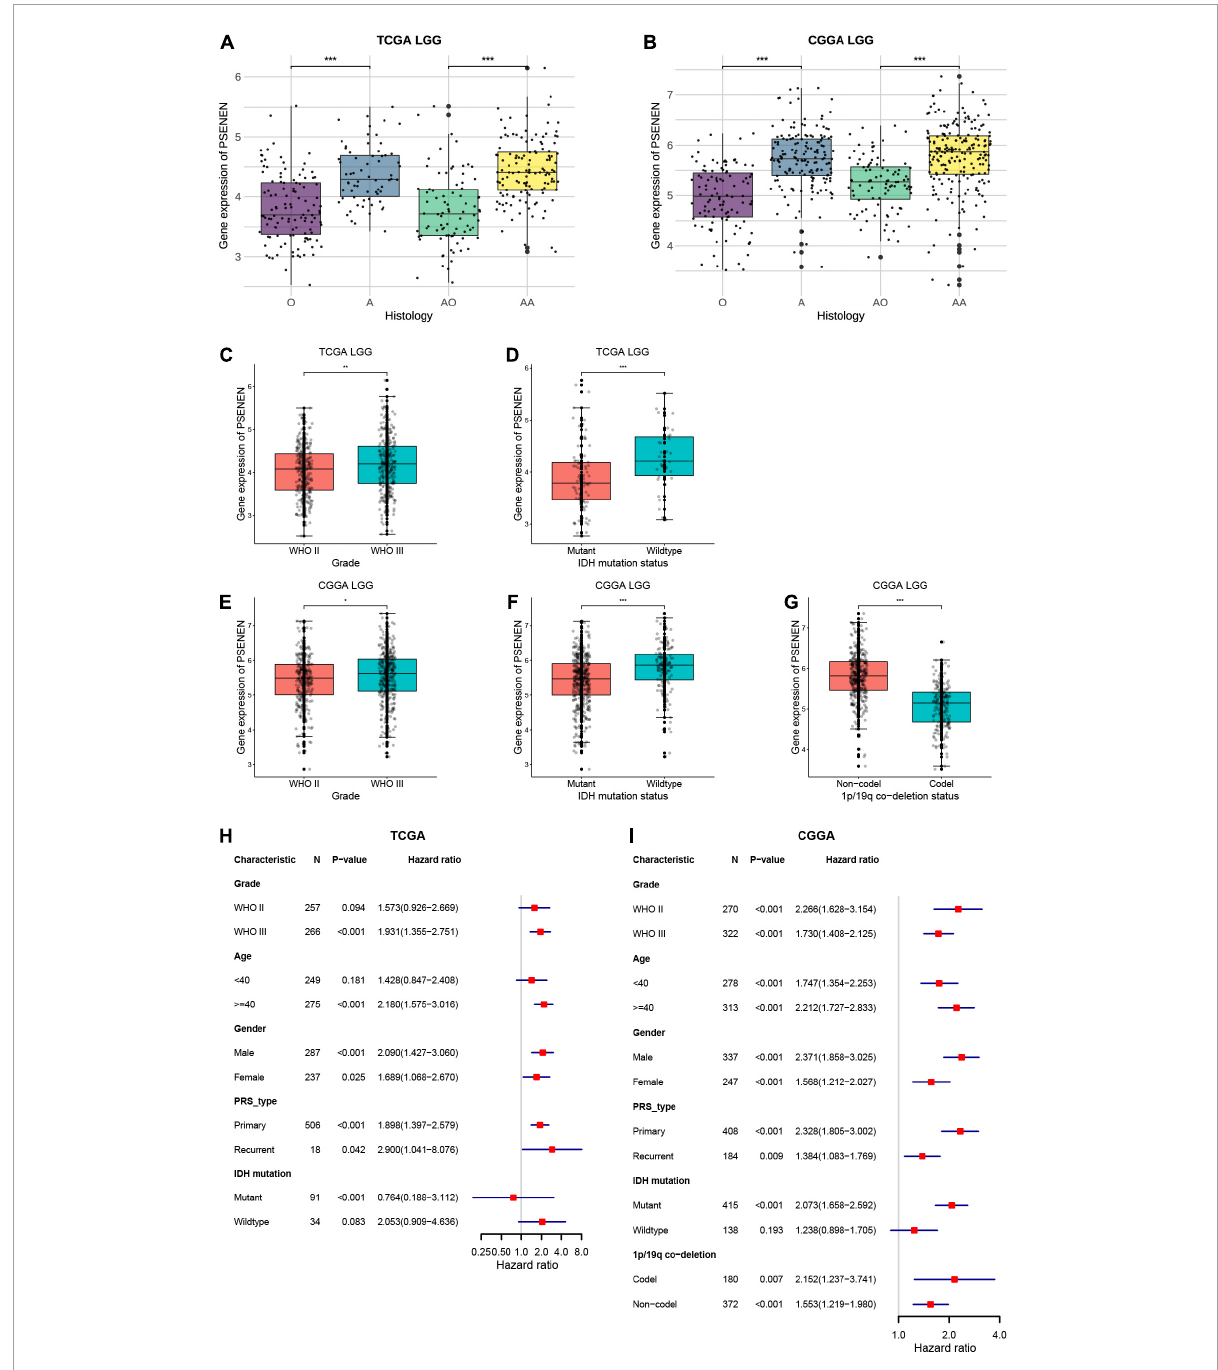
FIGURE3 Differential expression analysis and prognosis analysis of PSENEN in clinical subtypes of LGG. (A,B) The correlation of PSENEN expression level with histology in LGG of TCGA and CGGA databases. (C–G) The relationship between the PSENEN transcription level and WHO grade, IDH mutation, and 1p/19q codeletion in the CGGA and TCGA databases. (H,I) Forest plots show the correlation between PSENEN expression and clinical parameters in LGG from the TCGA and CGGA databases. “*”, “**” and “***” indicate p < 0.05, p < 0.01, and p < 0.001, respectively.